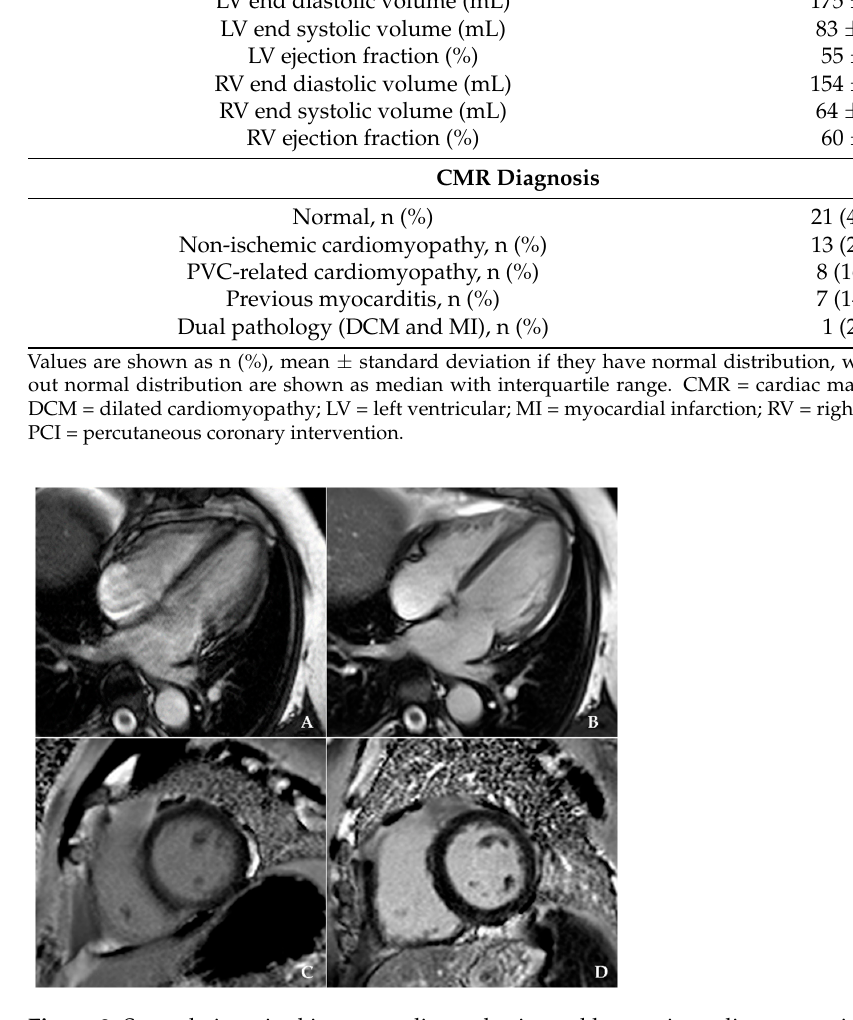
Figure 2. Severely impaired image quality on horizontal long-axis cardiac magnetic resonance cine imaging in a patient with a high ectopic burden ( A ), in contrast to the high-quality images after premature ventricular contraction (PVC) suppression with intravenous administration of procainamide ( B ). Late gadolinium enhancement image with impaired image quality of a patient with frequent PVCs ( C ), compared with the high-quality imaging in another patient with suppression of PVCs with procainamide ( D ). None of the patients developed significant QRS or QT interval prolongation, ad- vanced atrioventricular block or exacerbation of the ventricular arrhythmia. There was a small but statistically significant drop in blood pressure (BP) after procainamide admin- istration (mean change systolic BP − 12 ± 9 mmHg, p < 0.001; diastolic BP − 4 ± 9 mmHg, p = 0.012), but none of the patients developed symptomatic hypotension. There was no sig- nificant change in heart rate (HR) (mean HR change − 1 ± 6 bpm, p = 0.24) (Table 2). 4. Discussion CMR in patients with irregular heart rates, including frequent PVCs, remains chal- lenging due to artifacts. Our study showed that i.v. bolus procainamide successfully sup- pressed PVCs in 82% of patients with ventricular arrhythmias and significantly improved the image quality, enabling accurate measurements. Procainamide administration on the scanner table was not only effective, but also safe in our group of patients with normal or mildly reduced systolic function. CMR imaging in patients with arrhythmias constitutes a valuable diagnostic and prognostic tool. More specifically, CMR provides information regarding the underlying cause of and accurately assesses ventricular systolic function, which has been shown to predict adverse cardiac events. The pattern, location and extent of scarring or fibrosis can predict the improvement of cardiac function with treatment as well as future arrhythmic risk [9], in addition to guiding the device treatment or ablation of complex arrhythmias [10]. Importantly, in patients with ventricular arrhythmias, CMR has additional diagnos- tic value to conventional diagnostic investigations and can identify structural heart dis- ease, even in patients with normal echocardiograms [11].